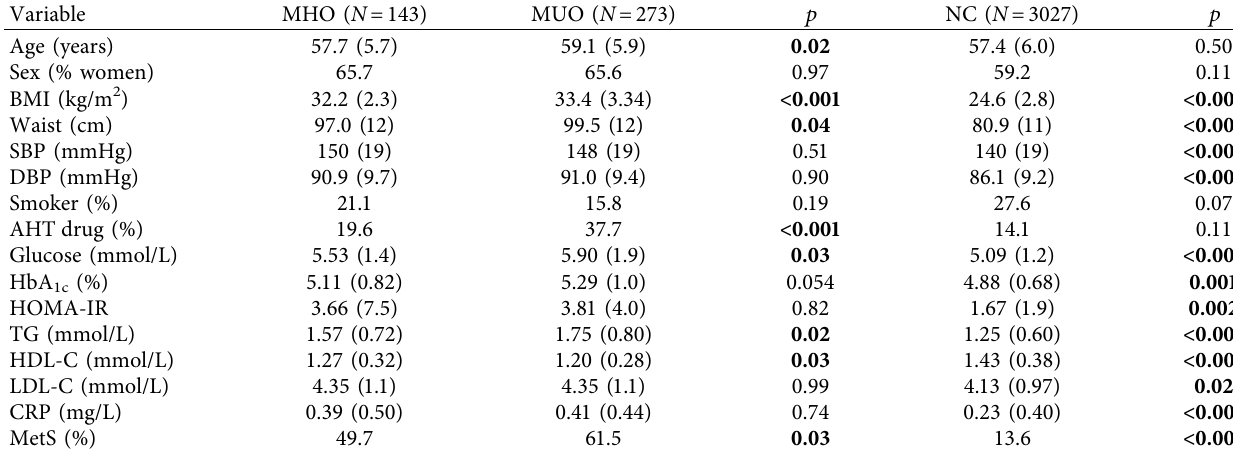
Table 1: Descriptive comparison and significance testing for MHO ( n � 143) compared to MUO subjects ( n � 273) and MHO compared to